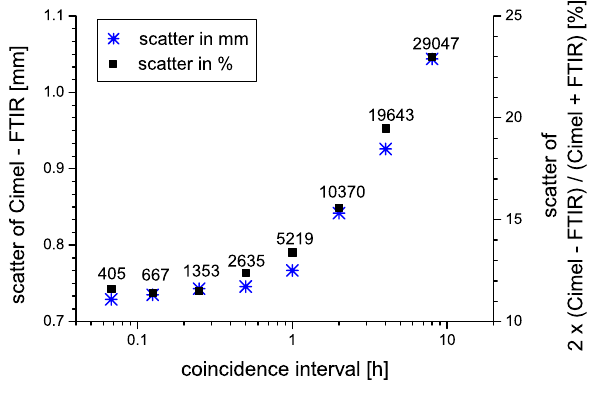
Fig. 4. 1 σ standard deviation of the PWV differences (scatter) between Cimel and FTIR as a function of temporal coincidence. Blue stars and left y-axis for Cimel-FTIR, black squares and right y-axis for (2 × Cimel − FTIR ). Indicated are the numbers of Cimel- Cimel + FTIR FTIR